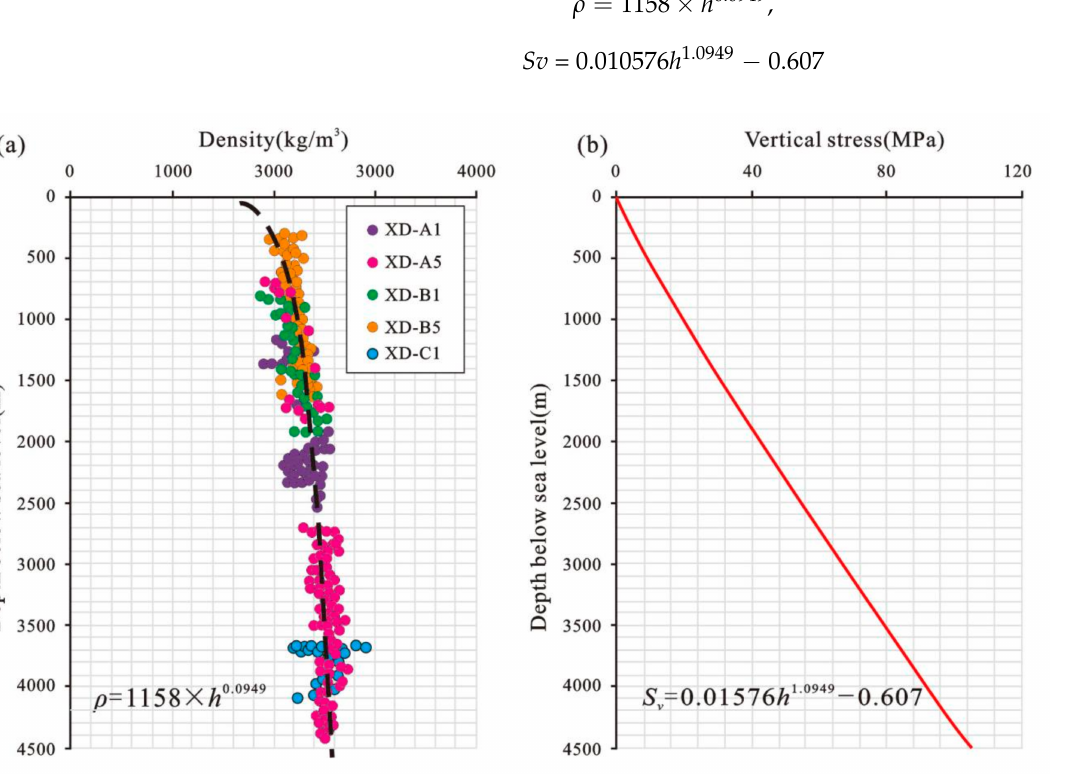
Figure 6. ( a ) The density measurements of 5 Wells in the three blocks of the study area. The relationship between density and depth follows a power function. ( b ) Vertical principal stress obtained by the density log from the 5 wells. The vertical stress gradient is shown to increase with depth and close to 22.8 MPa/km in Huangliu